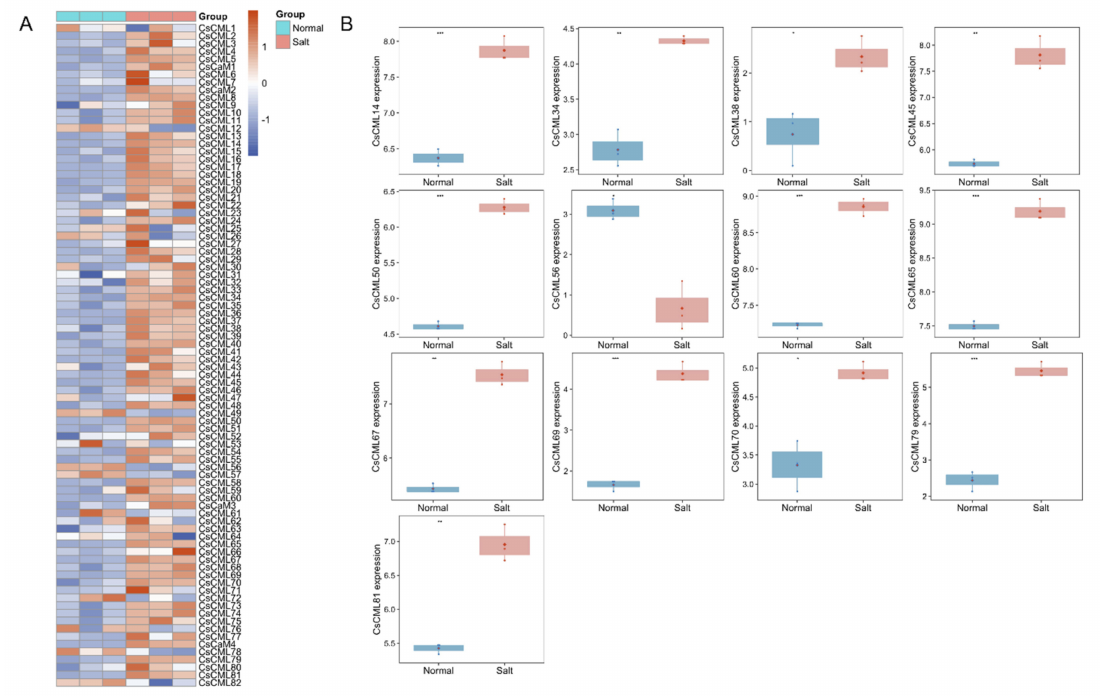
Figure 6. Expression of CsCaM/CML genes under salt stress. ( A ) Gene expression levels of CsCaM/CML gene family member response to salt stress were depicted with the heatmap;